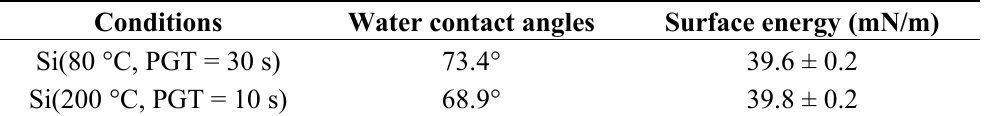
Table 2. The water contact angles and surface energies of thin films deposited through Atomic Layer Deposition (ALD) under different